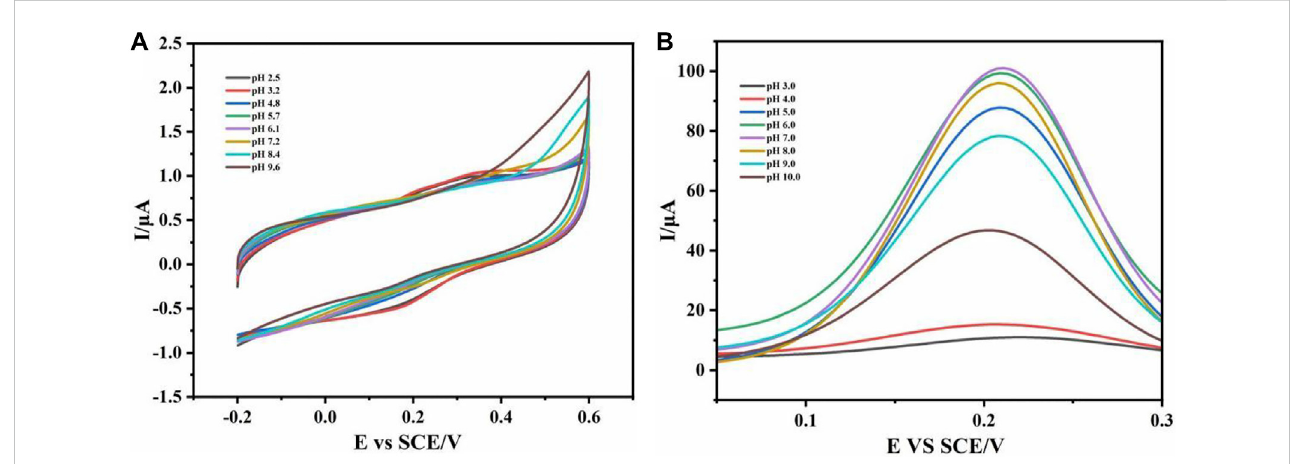
FIGURE 4 CV curve (A) and DPV curve (B) were detected in different pH reaction solution